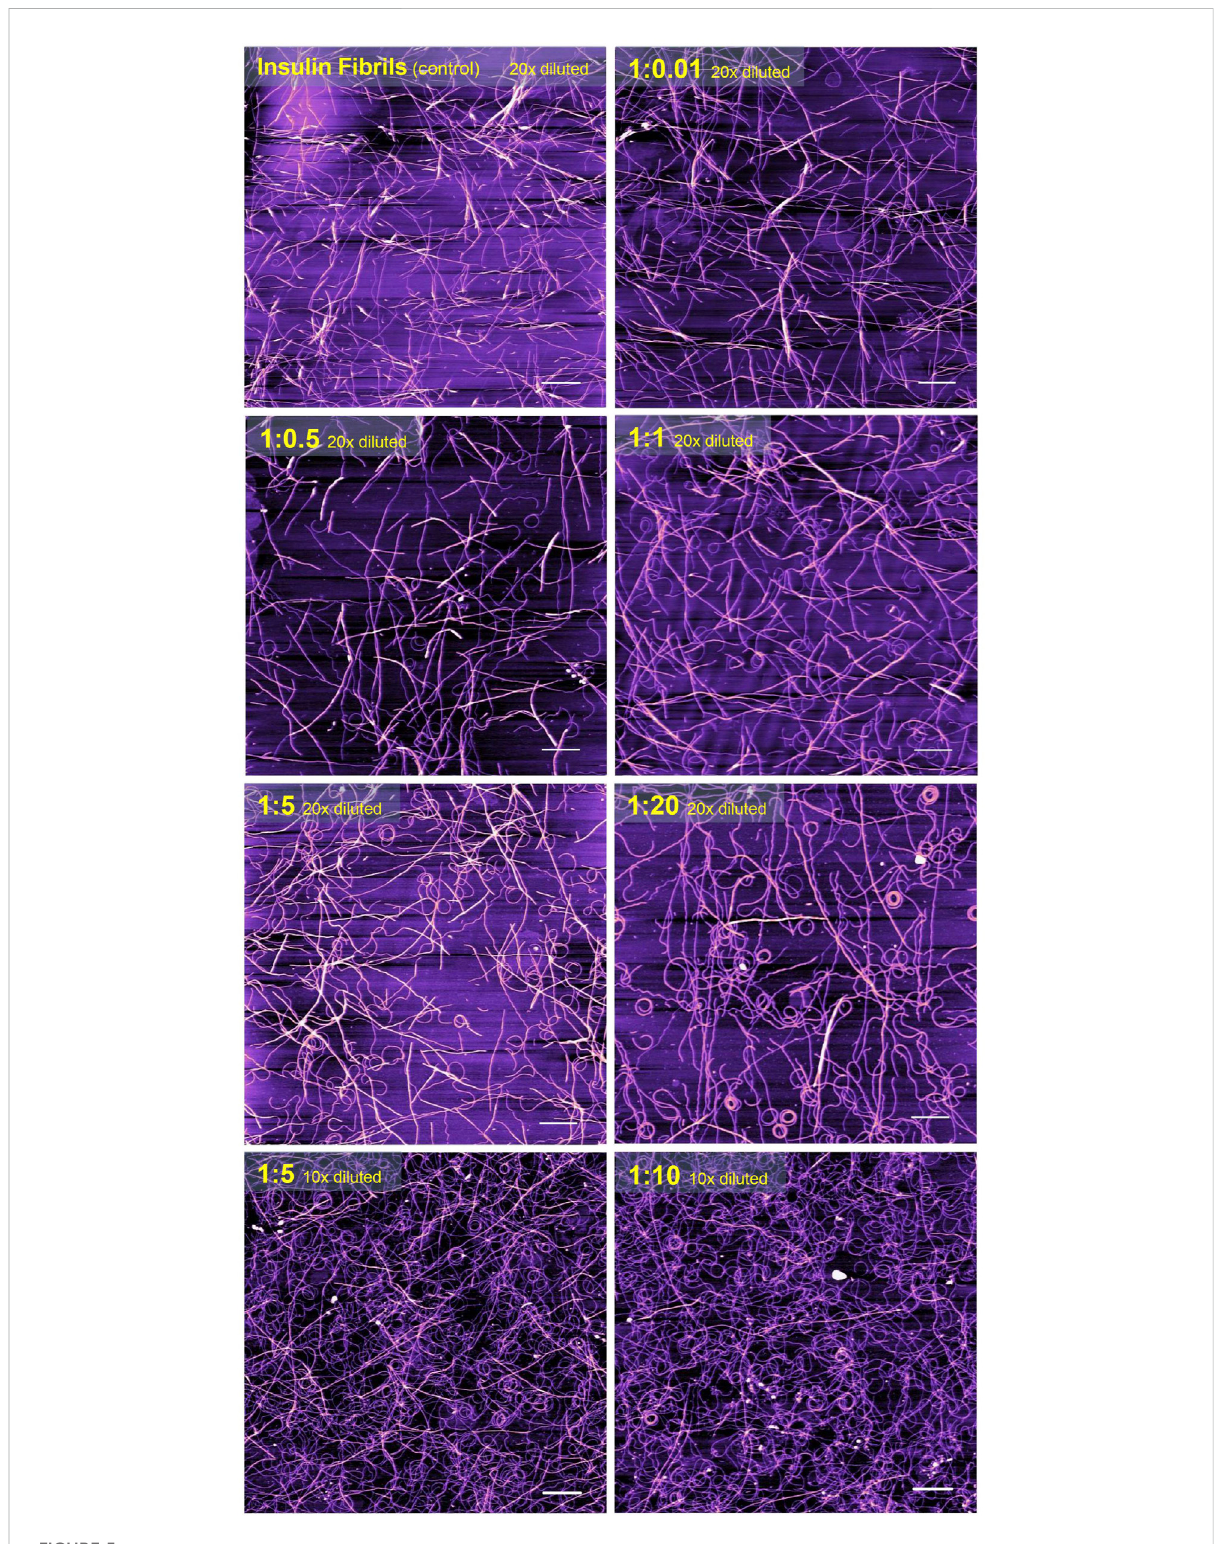
FIGURE 5 The atomic force microscopy visualization of insulin amyloid fi brils formed alone ( control ) and in the presence of different concentrations of Chobimalt. White scale bars always represent 1 µm. The images were processed using NanoScope Analysis 1.20 software.